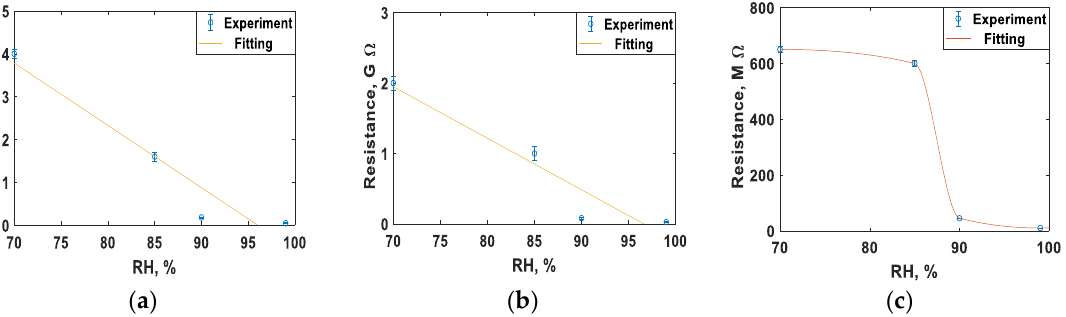
Figure 11. Resistance change with variable RH at different times of humidity exposure: ( a ) 6 min, ( b ) 10 min, and ( c ) 20 min.